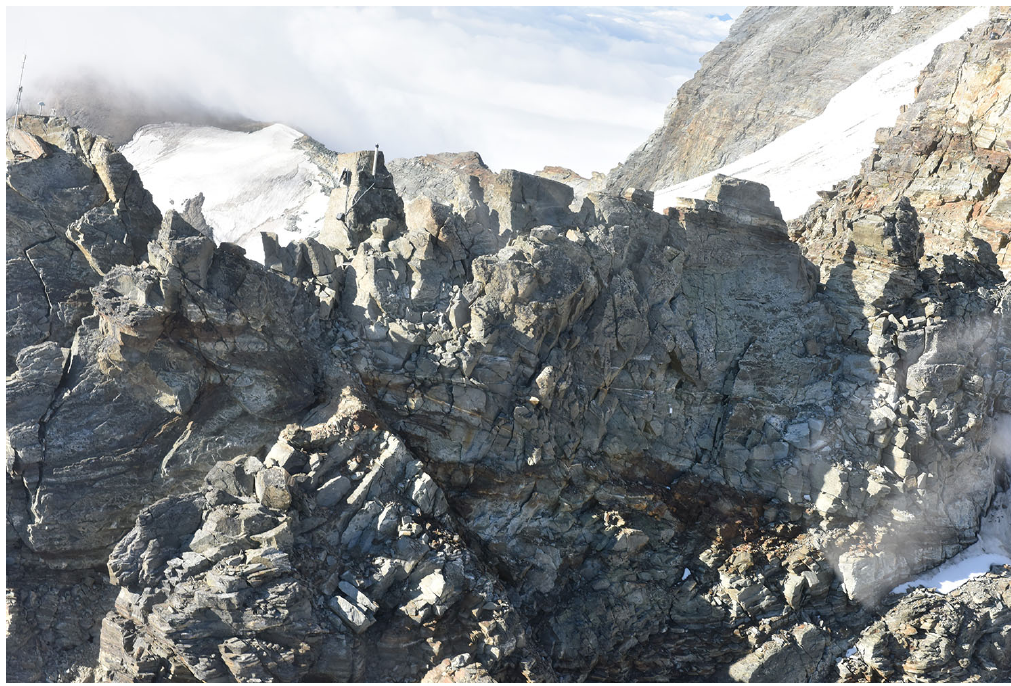
Figure C3. Close-up from the north onto the Hörnligrat with the weather station visible on the top left and the MH11.